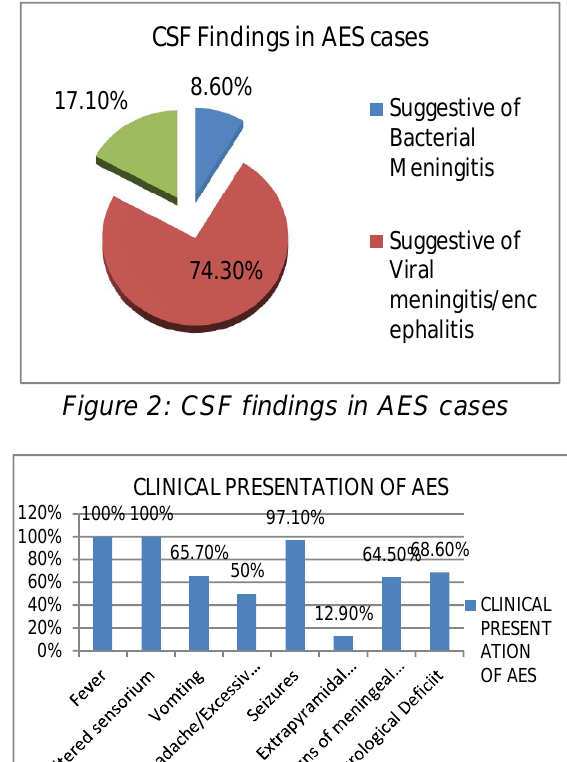
Figure 3: Clinical presentation of